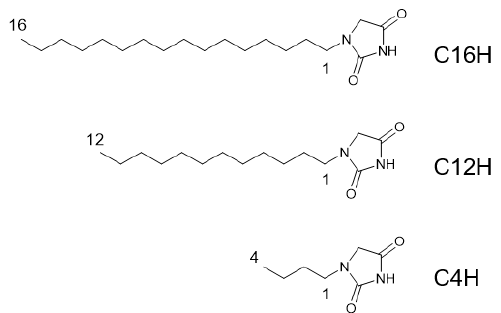
Figure 1. Chemical structures of N -alkylhydantoins in this study.